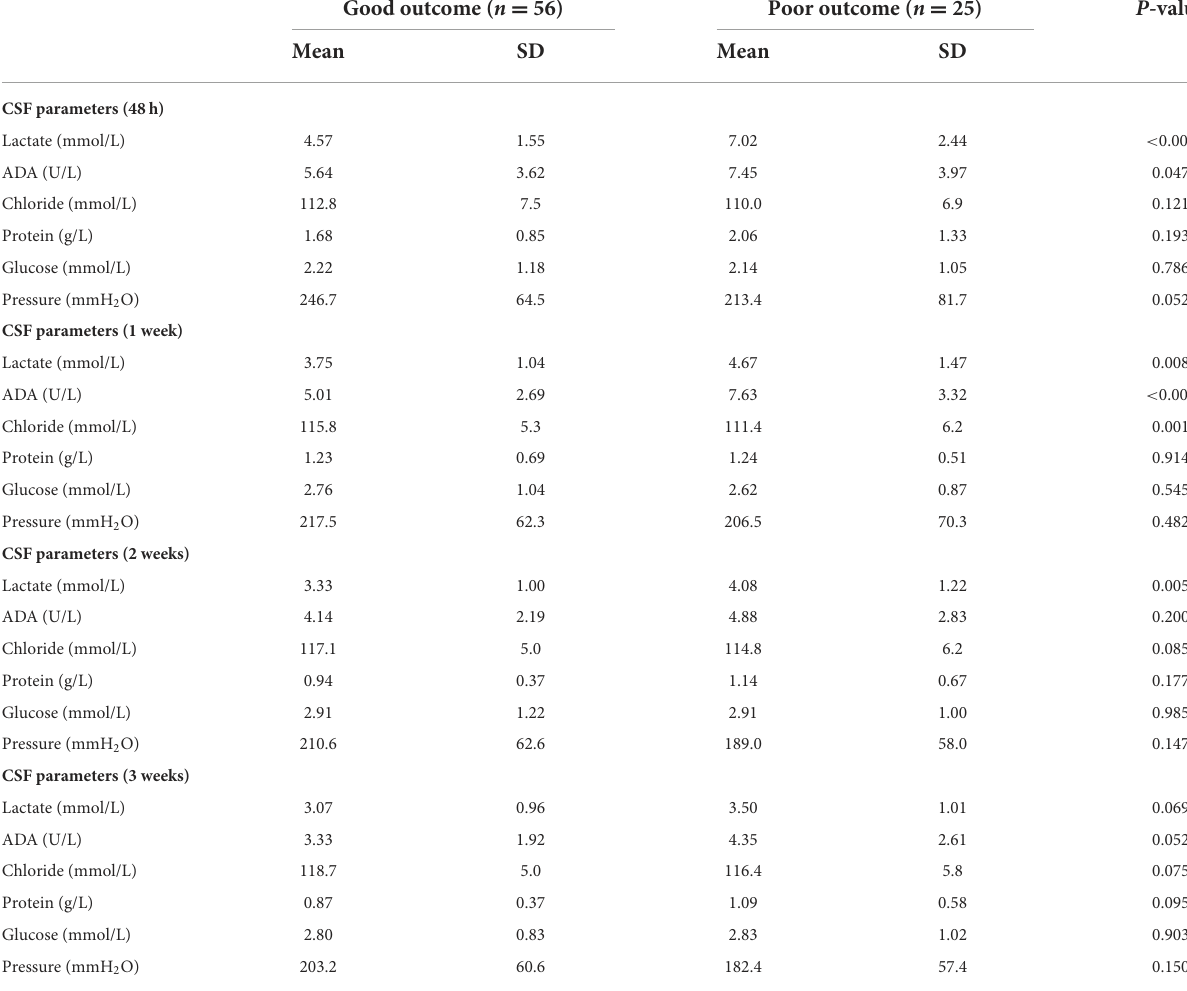
TABLE 2 Comparison of cerebrospinal fluid parameters between the two groups at four different time points after admission. Good outcome ( n = 56) Poor outcome ( n = 25) P -value Mean SD Mean